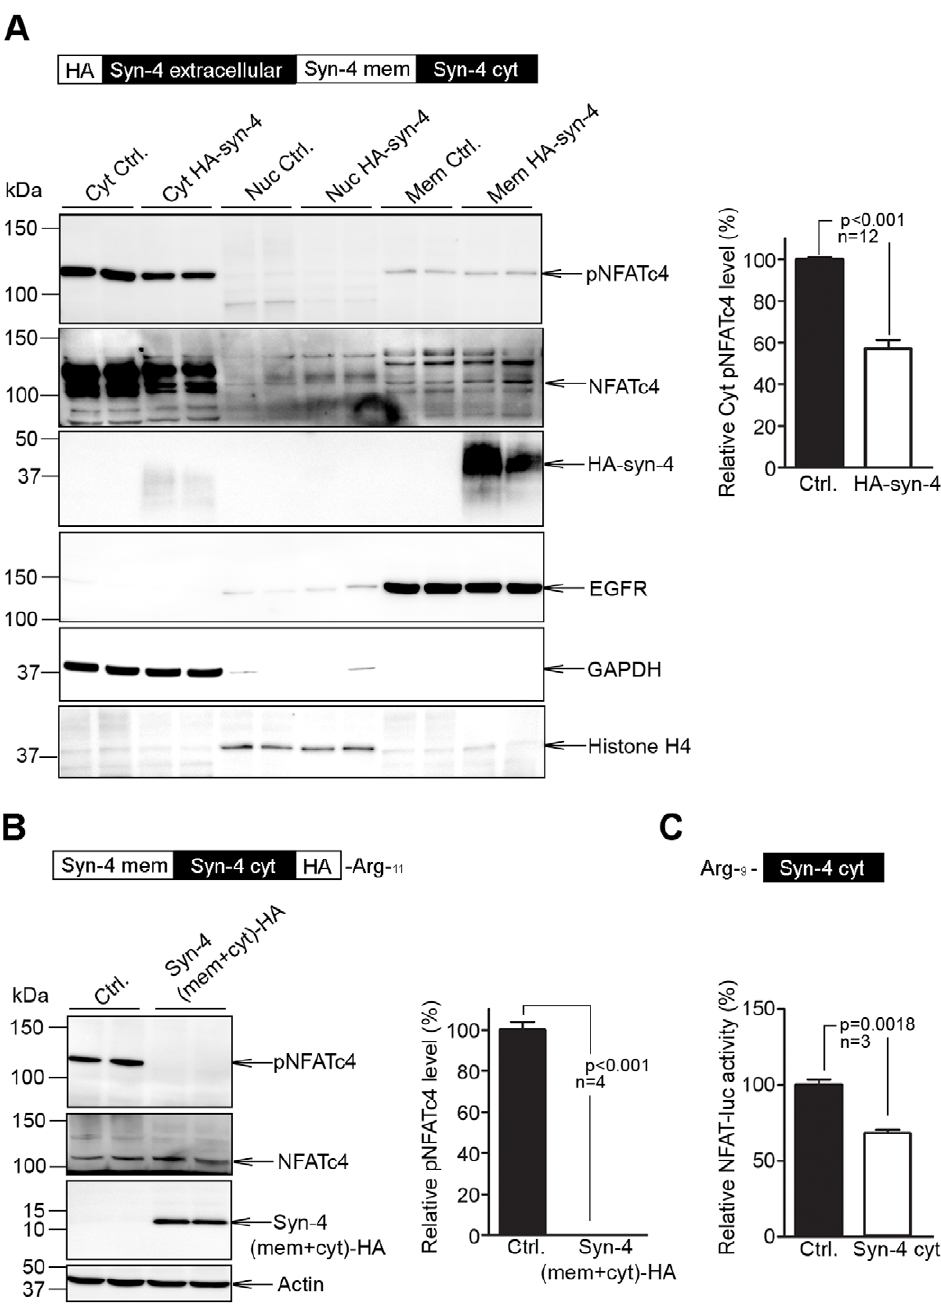
Figure 3. Membrane-localized syndecan-4 activates nuclear factor of activated T-cell (NFAT) invitro . Phosphorylated NFATc4 (pNFATc4), NFATc4 and syndecan-4 levels in (A) HEK-293 cells overexpressing full-length HA-tagged syndecan-4 (HA-syn-4, Cyt=cytoplasmic, Nuc=nuclear, Mem=membrane, EGFR=epidermal growth factor receptor (marker of membrane fraction)) (n=12). Wild-type (WT) cardiomyocytes treated with a cell-permeable peptide consisting of the membrane and cytoplasmic parts of syndecan-4 (syn-4 (mem + cyt)-HA) (n=4), analyzed by immunoblotting (B), and NFAT-luciferase reporter cardiomyocytes treated with a cell-permeable peptide consisting of the cytoplasmic part of syndecan-4 only, analyzed by luciferase activity (n=3) (C). GAPDH, histone H4, EGFR and actin were used as loading controls. Values are mean 6 s.e.m.